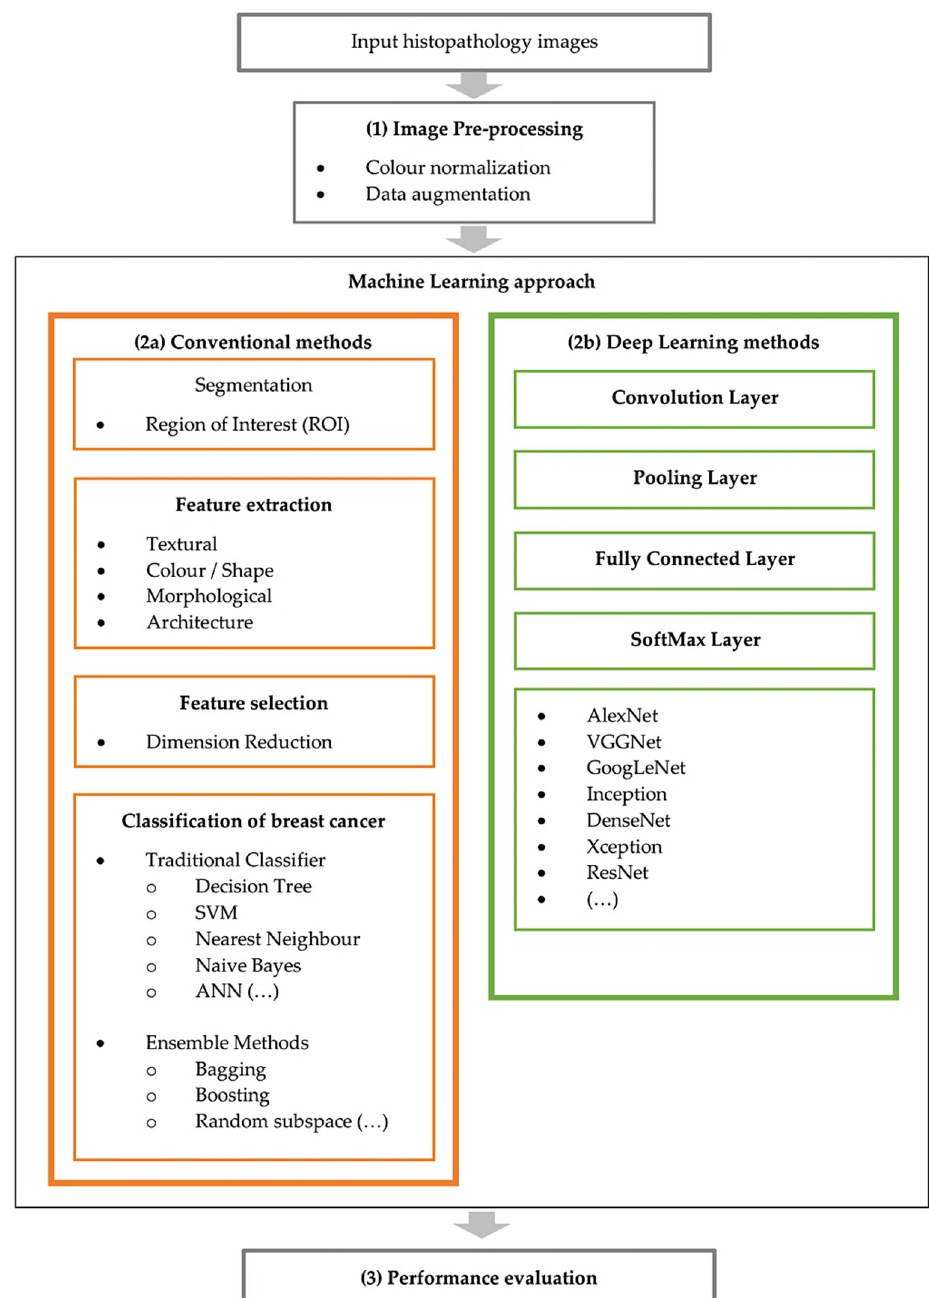
Figure 6. Overview structure of methods used to classify breast cancer in CAD systems.